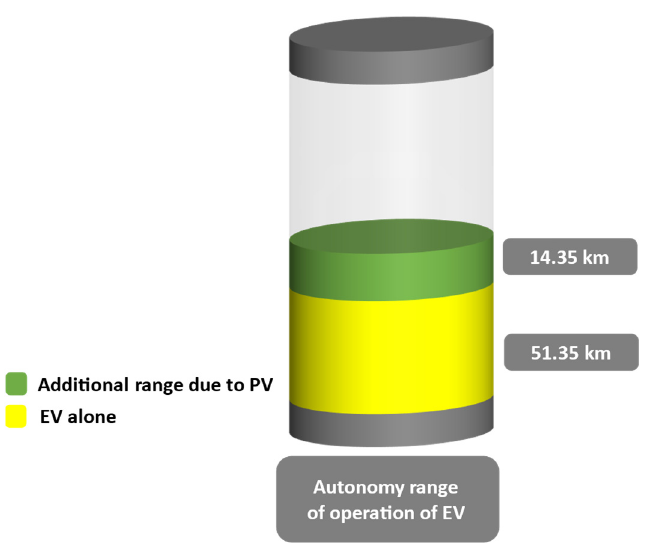
Figure 13. Increase in the range of a Chock S2 EV.